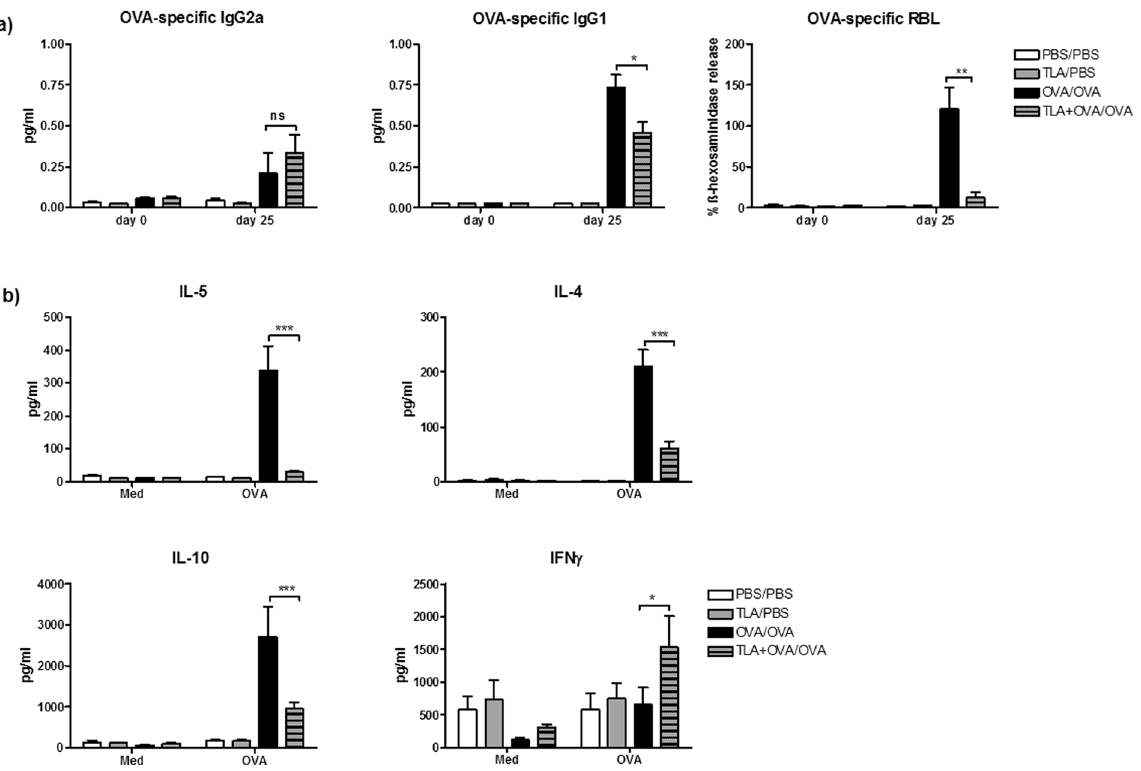
Figure 5. Effect of TLA on the development of systemic immune responses. Mice were treated as indicated in Fig. 3a. Serum and spleens were collected on day 25. Levels of OVA-specific IgG2a and IgG1 were determined by ELISA. Degranulation of rat basophil leukaemia cells (RBL) by cross-linking of the FceRI-bound IgE with allergen (0.3 µ g/ml OVA) was measured by the production of β -hexosaminidase ( a ). Levels of cytokines in supernatants from spleen cells cultured with media only (Med) or 50 µ g/ml OVA for 72 h was measured by ELISA ( b) . Data are representative of three experiments (n = 5 mice per group). Results of ANOVA test: * P < 0.05, ** P < 0.01, *** P <